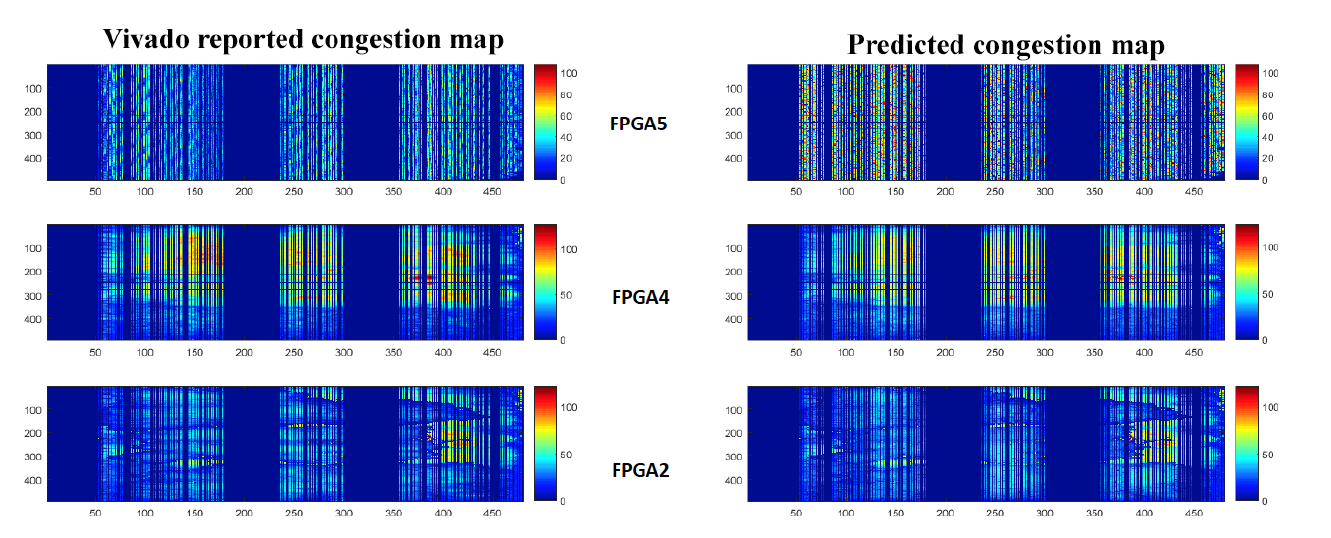
Figure 8. Visual comparison of congestion density plots between actual congestion reported by Xilinx tools and the congestion predicted by the prediction